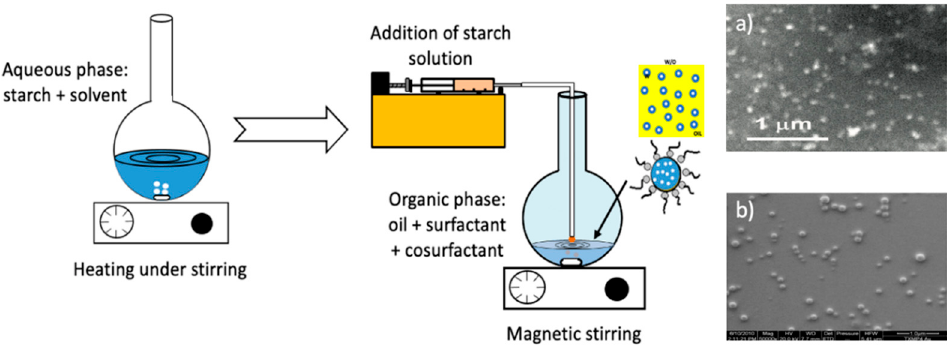
Figure 3. Synthesis of SNPs through emulsion/microemulsion method and SEM micrographs of ( a ) corn SNPs [27] and ( b ) potato SNPs [28].